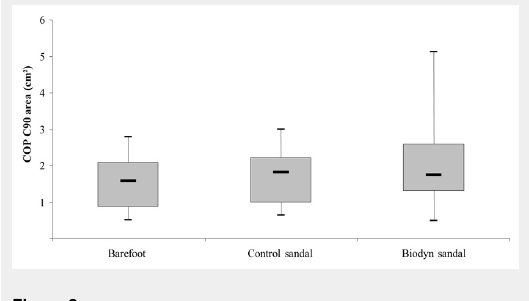
Box plots comparing centre of pressure (COP) C90 area (i.e., surface area covered by the trajectory of the COP with a 90% confidence interval) between testing conditions obtained during bipedal stance.